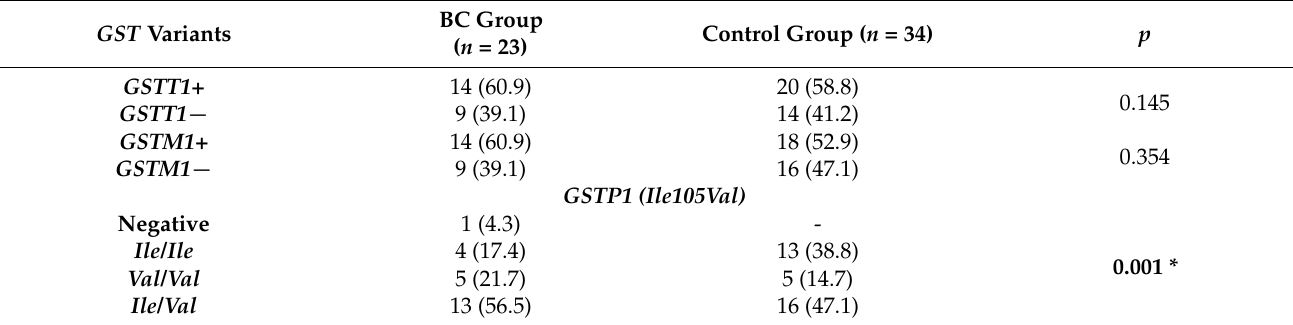
Table 4. GST variants among participants according to study